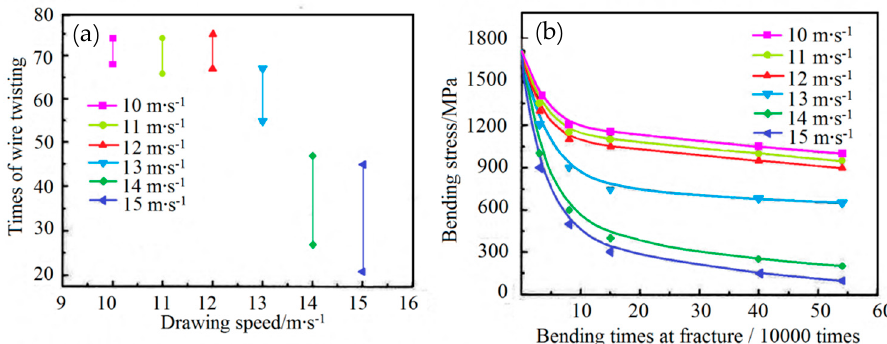
Figure 33. Bending fatigue limits of filaments at different wet drawing speeds: ( a ) torsion number and ( b ) bending fatigue limit. Reprinted with permission from ref. [83].